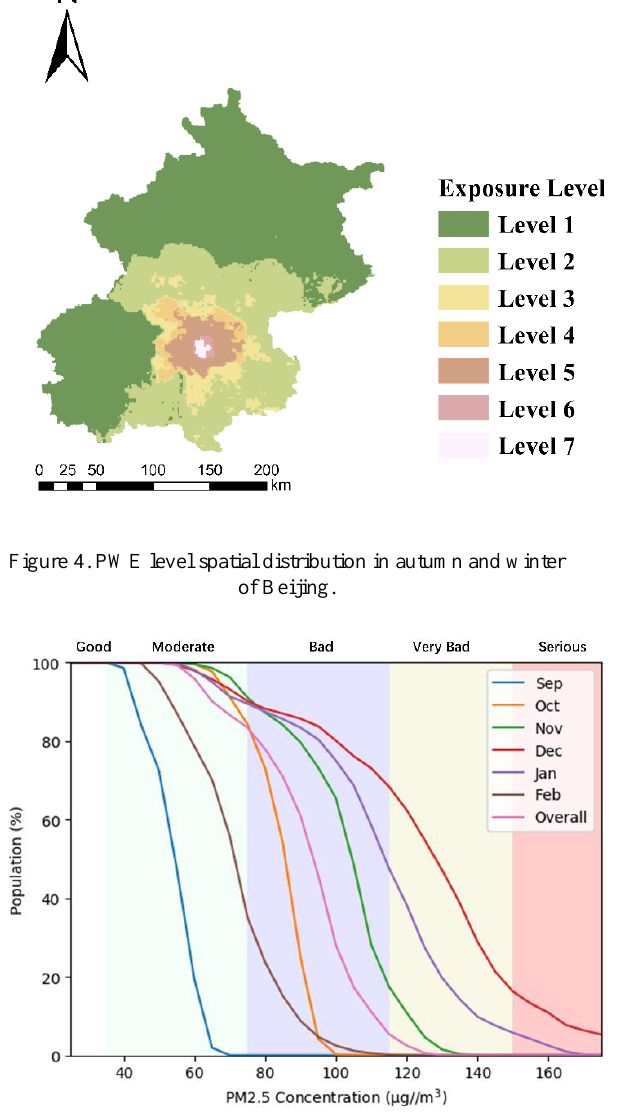
Figure 5. Beijing population proportion exposed to